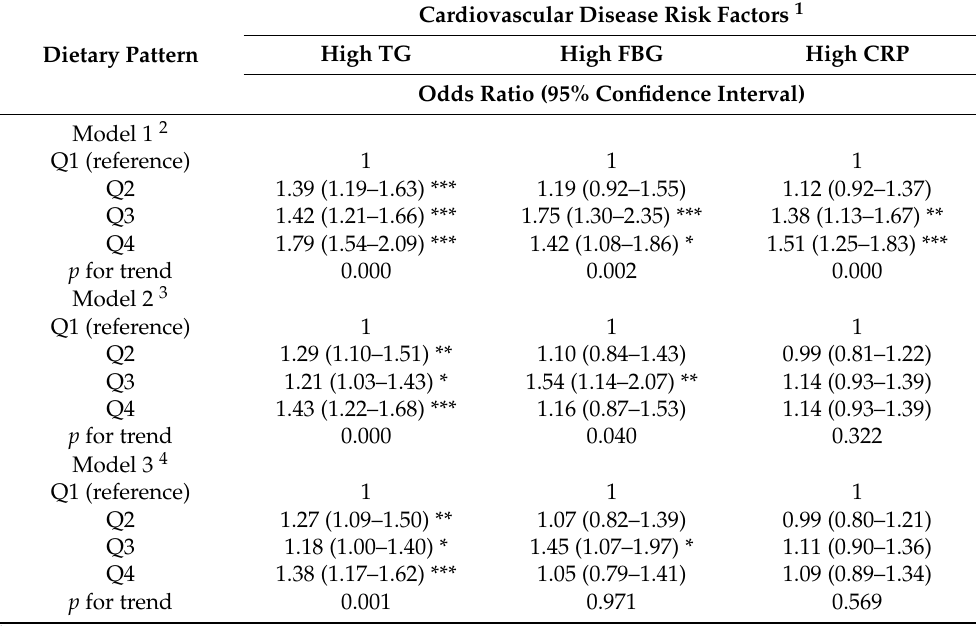
Table 5. Binary logistic regression for the association between the dietary pattern, triglycerides (TG), fasting blood glucose (FBG), and C-reactive protein (CRP) ( n = 5689).